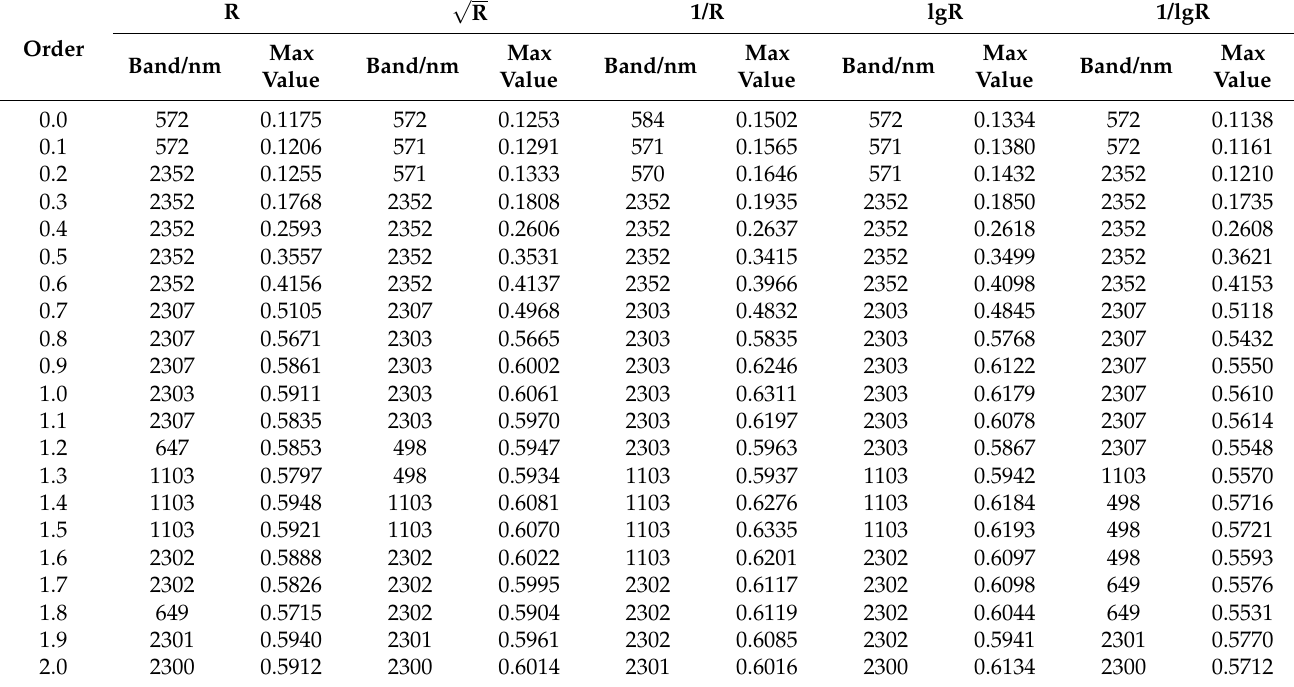
Table 4. The absolute value of the maximum correlation coefficient between the hyperspectral and Na + in Area A and its corresponding band.